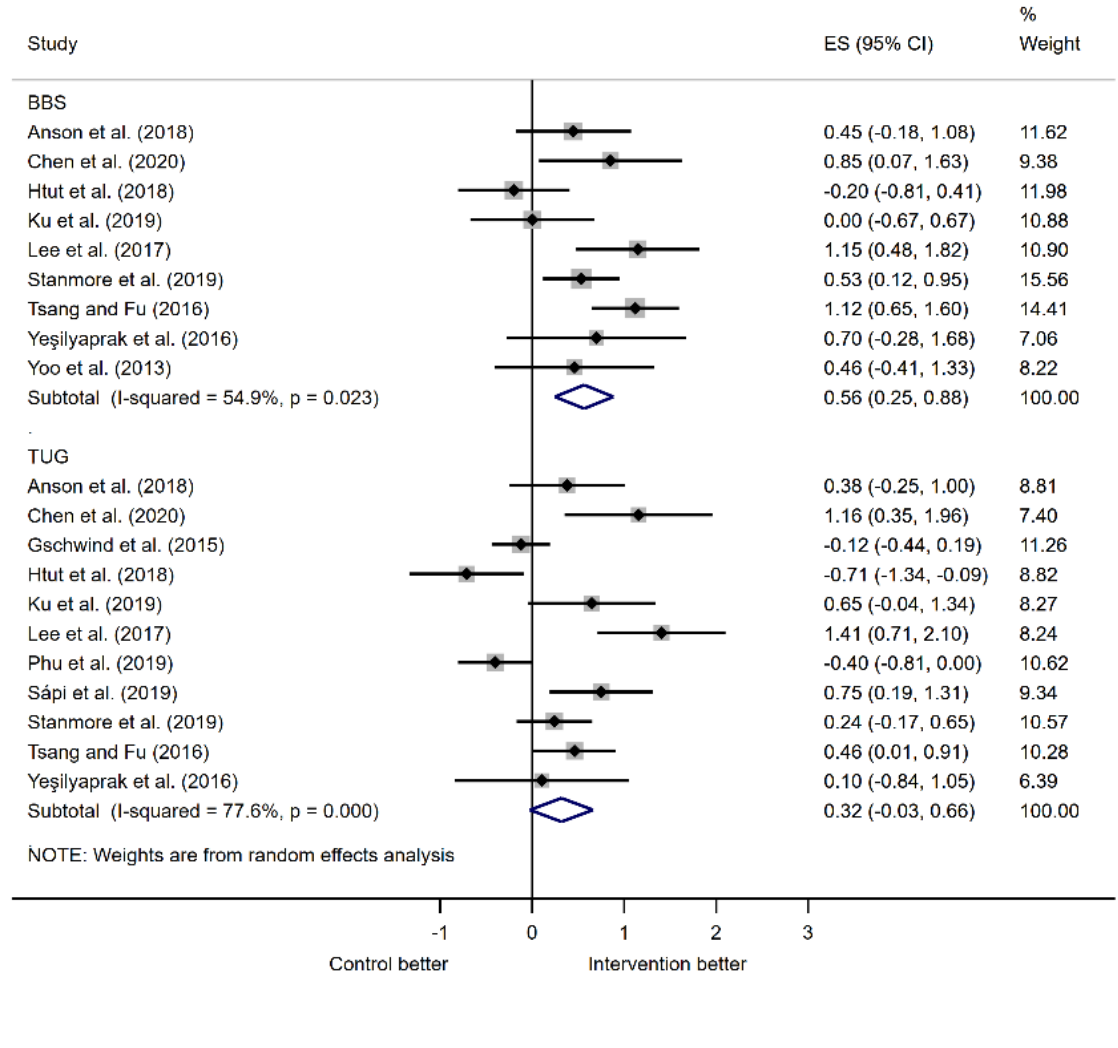
Figure 4. Meta-analysis forest plot [28, 44, 45, 47, 48, 50-52, 55, 57, 59,